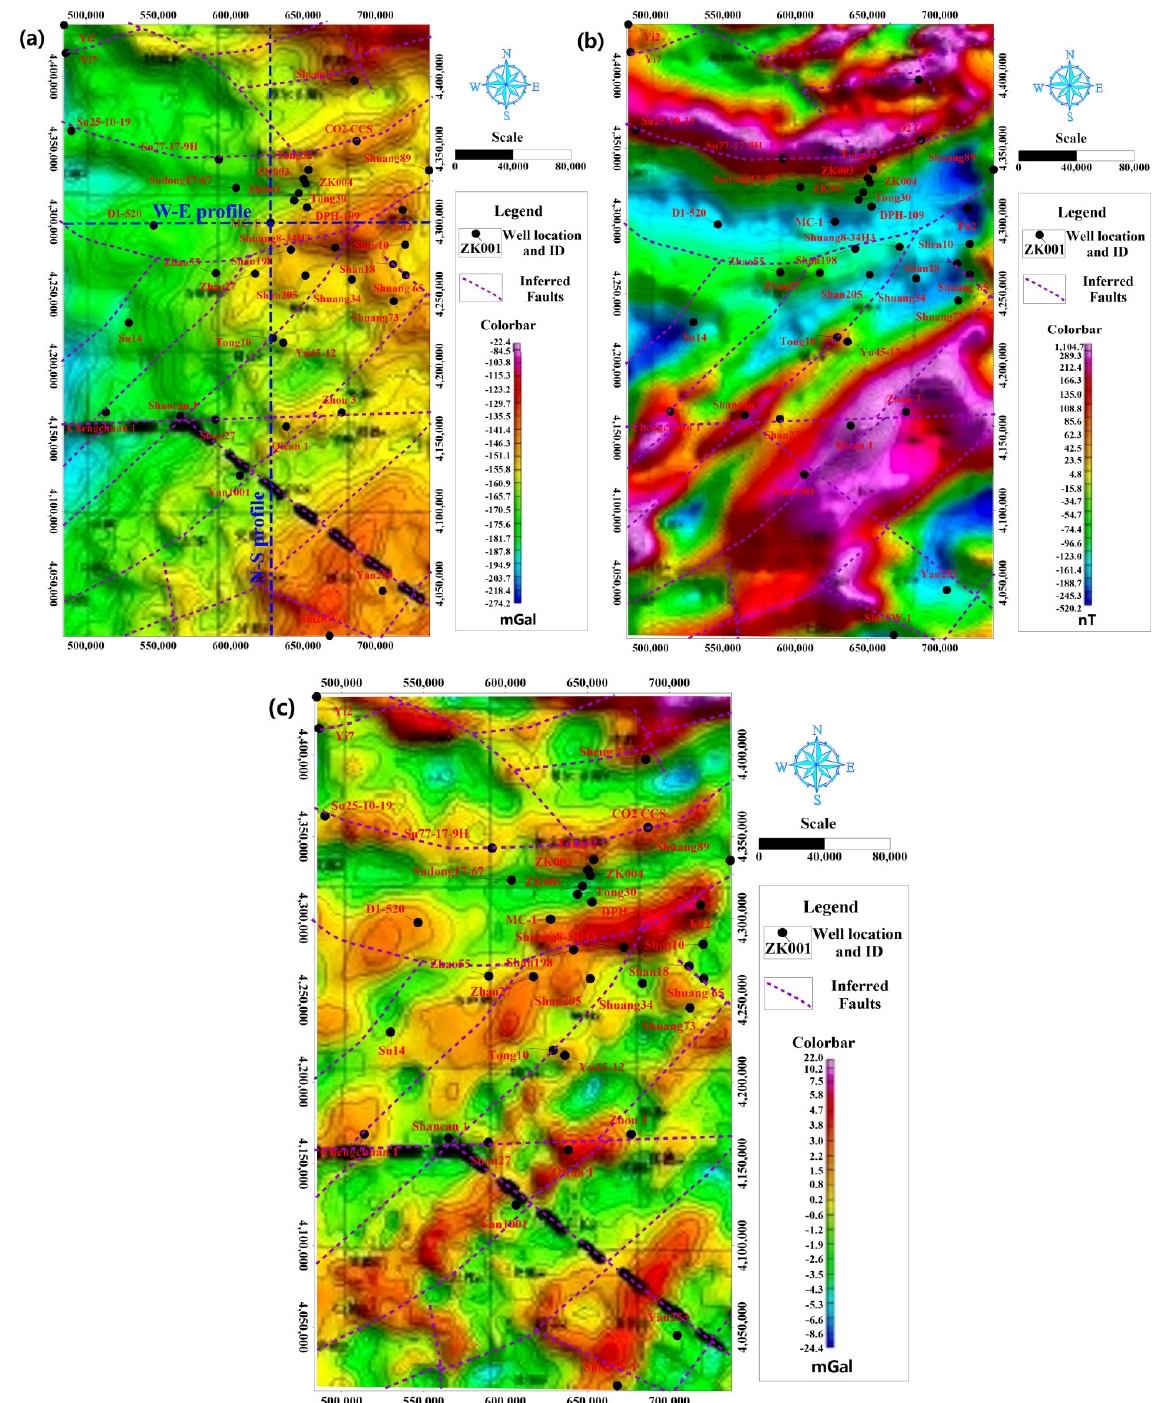
Figure 4. ( a ) Bouguer gravity anomaly, ( b ) Reduction-to-the-pole of magnetic anomaly, ( c ) Small- scale of residual gravity anomaly for the study